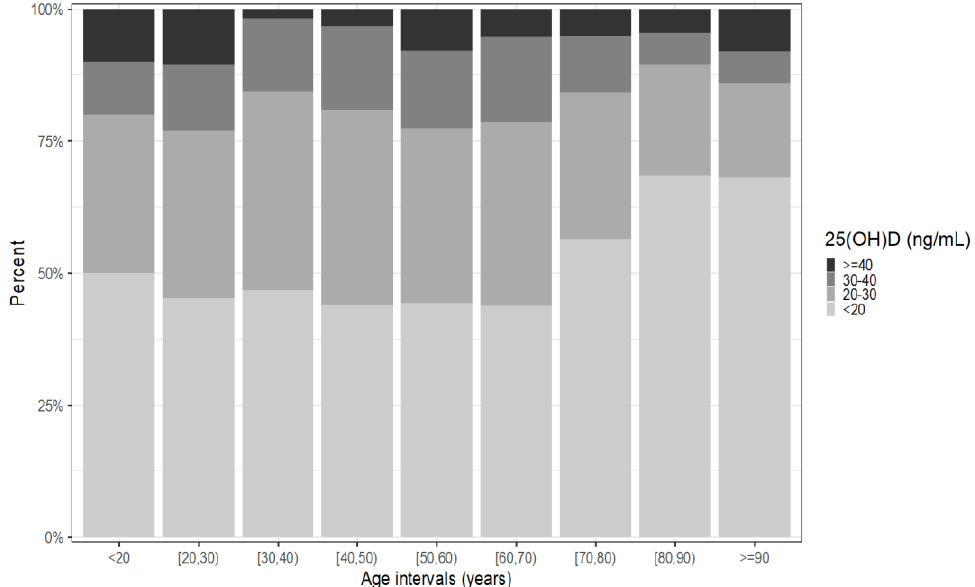
Figure 1. The 25(OH)D serum concentration distribution according to age intervals.